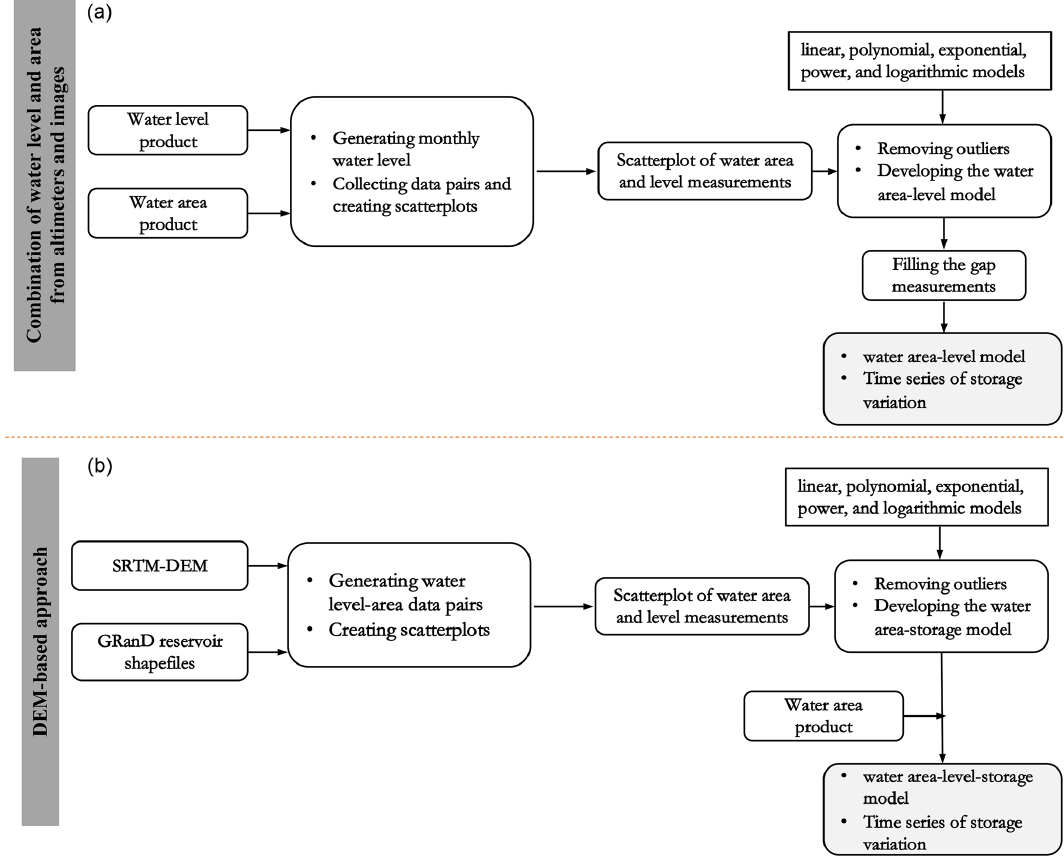
Figure B2. Flowchart of obtaining water storage variation using reservoir water area from satellite imagery and water level from satellite altimetry (a) . Flowchart of obtaining water storage variation using surface water area from satellite imagery and SRTM DEM (b) .